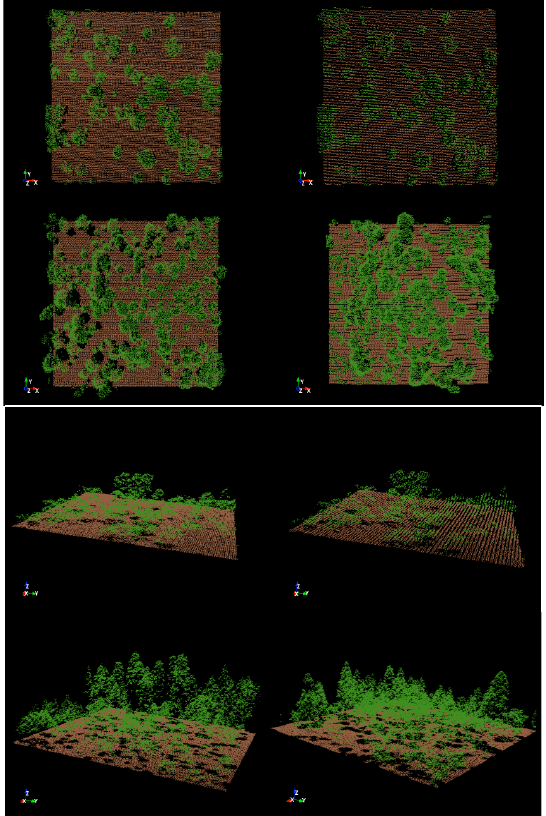
Figure 2: Selected LiDAR point clouds from the NEON AOP system, shown in nadir and oblique view. The two panels show the four plots in corresponding order. Top left: SJER, site AOP116, flight line 3; Top right: SJER, site AOP116, flight line 12; Bottom left: SOAP, site AOP143, flight line 10; Bottom right: SOAP, site AOP299, flight line 7. Each plot represents 200 x 200 m. Note the distinct horizontal and vertical structural differences between the SJER and SOAP